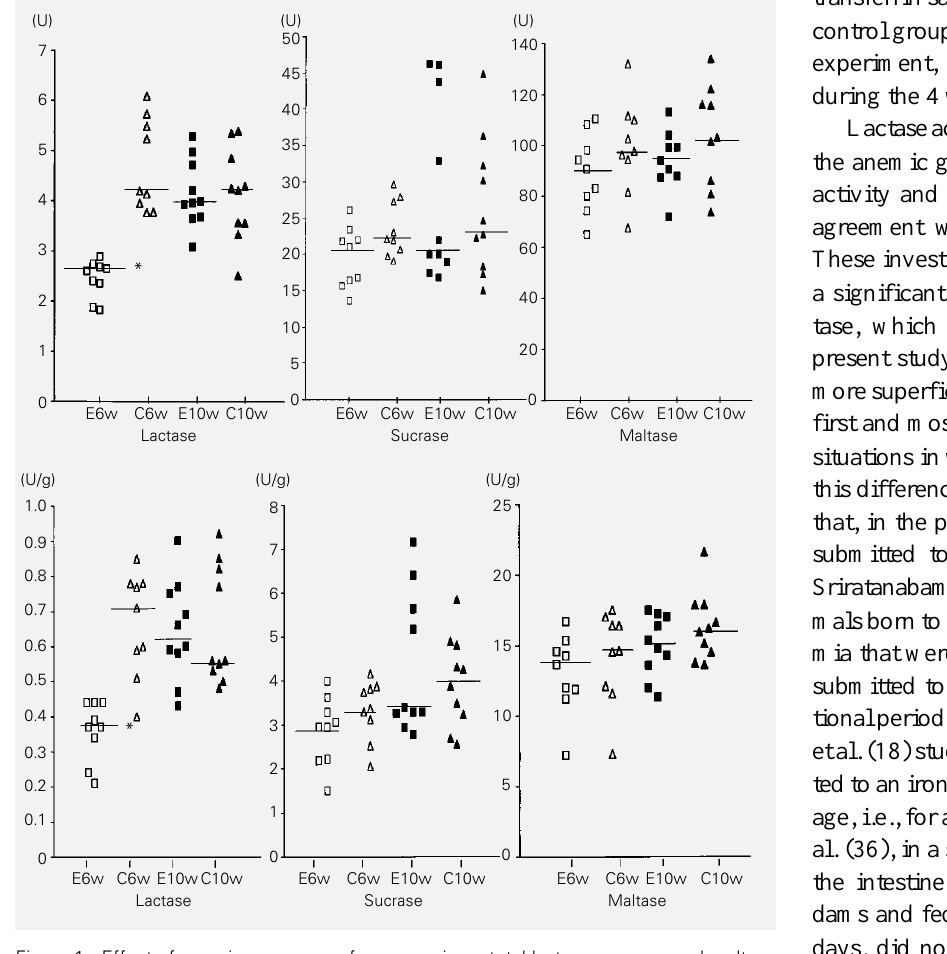
Figure 1 - Effect of anemia or recovery from anemia on total lactase, sucrase and maltase activity of the small intestine (top) and on specific enzyme activity per gram small intestine wet weight (bottom). Data are reported as individual values, with the median indicated by the horizontal bars. E6w = Anemic; E10w = recovered anemic; C6w and C10w are the appropriate controls. *P<0.05 compared to the other groups (nonparametric Mann-Whitney